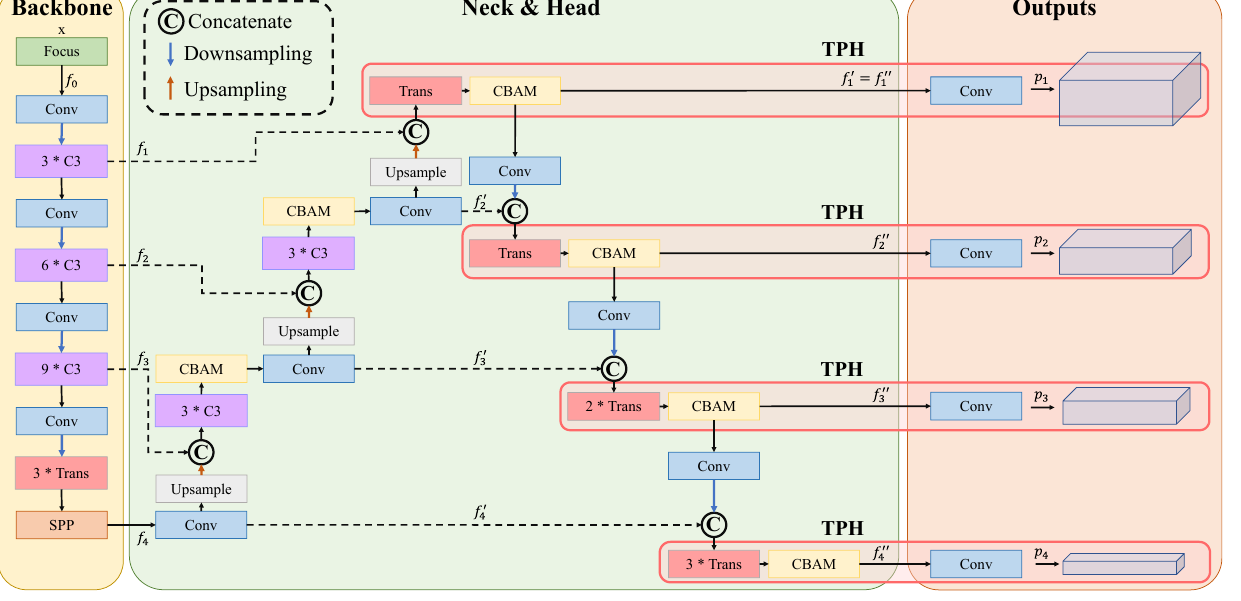
Figure 3. The architecture of TPH-YOLOv5. TPH-YOLOv5 introduces an additional head, trans- former prediction head (TPH), and convolutional block attention module (CBAM). Four prediction heads are named tiny, small, medium, and large heads, and the branches before these heads are tiny, small, medium, and large